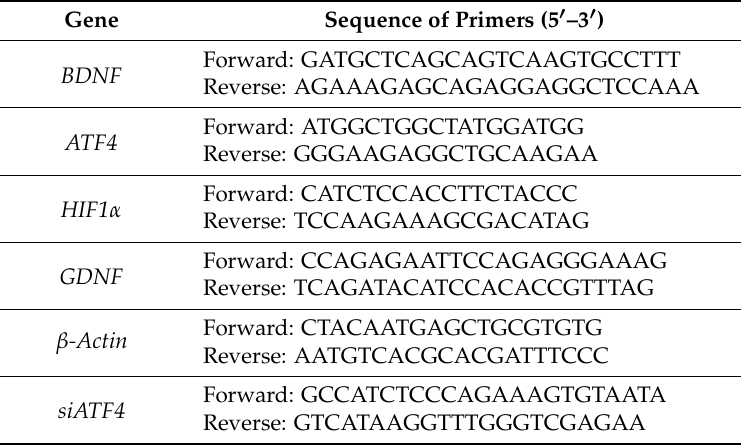
Table 1. RT-PCR primers and siRNA (RT-PCR = reverse transcription-polymerase chain reaction). Gene Sequence of Primers (5 (cid:48) –3 (cid:48)